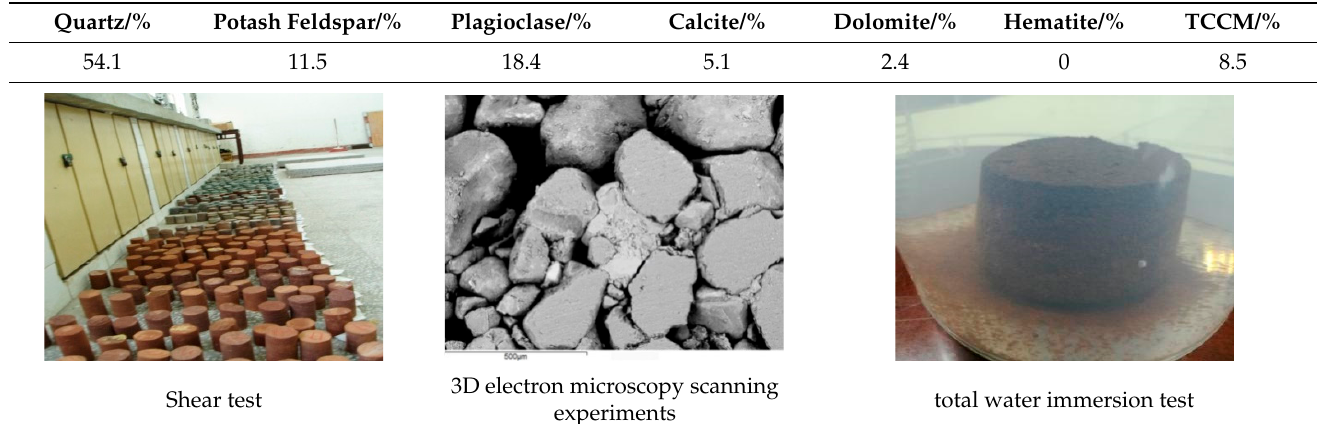
( a ) ( b ) Figure 5. Local filling–caving multi-faces coordinated mining in deep areas; ( a ) schematic design. ( b ) Underground live. Coal mining-induced strata movement is a complicated problem that combines time and space. It takes place under the influence of multiple factors. It is determined by geo- logical mining conditions (e.g., overlying rock lithology, mining depth, and mining thick- ness), mining mode, and mining space together. The strata movement and energy polling distribution control methods during local filling–caving multi-faces coordinated deep mining based on the main key stratum not only make full use of the control effect of the key stratum and advantages of partial filling mining but are also restricted by correspond- ing influencing factors. Based on the comprehensive analysis, the major factors could be divided into three types: (1) mining scale, filling scale, and section pillar scale; (2) filling technology; and (3) geological mining conditions (Figure 6).